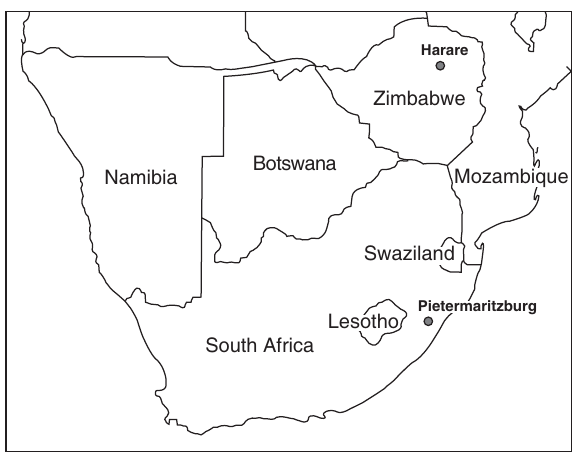
FIG. 1 Map of Zimbabwe and South Africa showing the approx- imate geographical locations of Harare (where the 2-year- old colt originated) and Pietermaritzburg (where it sub- sequently developed clinical signs compatible with rabies)